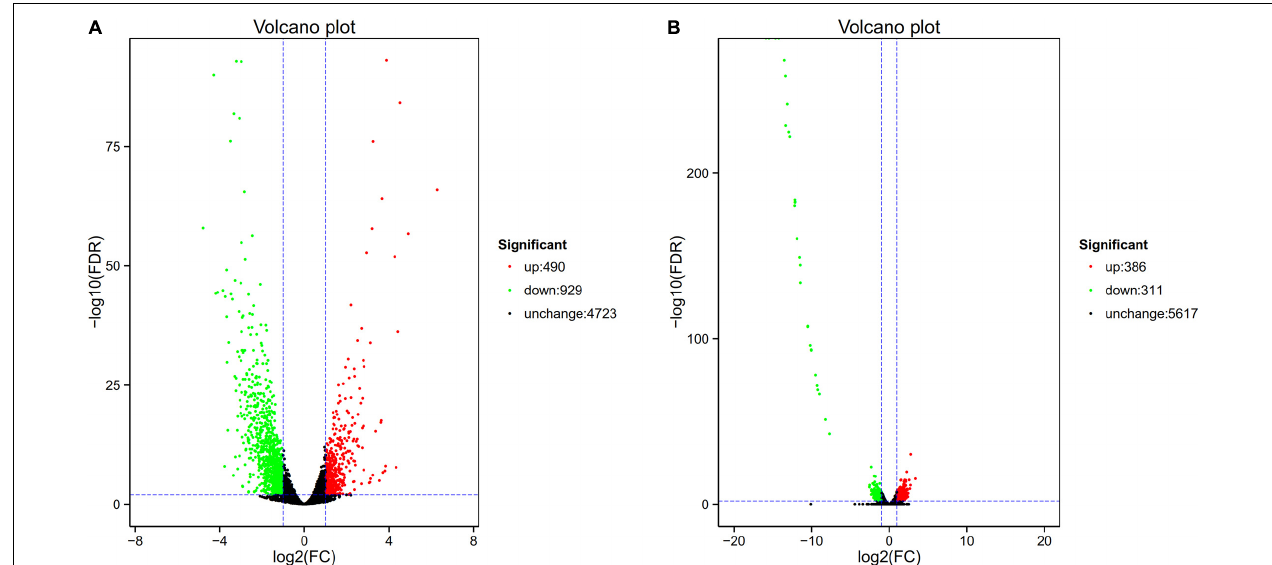
FIGURE 1 | Volcano plot of differential expression in PA1.2620 different strain. (A) PA1.2620 original strain vs. PA–60 mutant. (B) PA-60 strain vs. PA–99 mutant. Each point in volcano plot represents one gene, and the abscissa represents the logarithm of the expression difference fold of one gene. The vertical axis represents the negative logarithm of the error detection rate. The green dots represent down-regulated genes, the red dots represent up-regulated genes and the black dots represent unchanged genes.